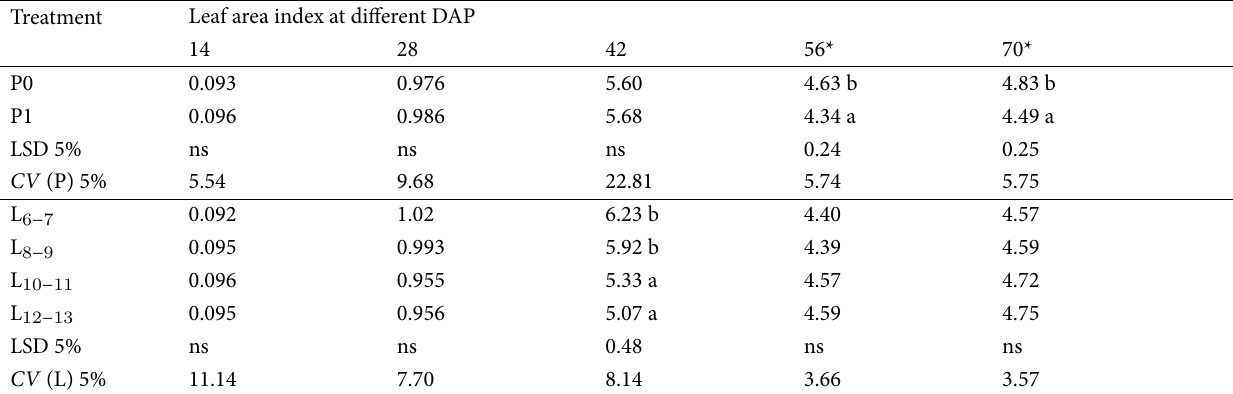
Table 2 Effects of bud trimming and fruit position arrangement on the leaf area index at 14, 28, 42, 56, and 70 DAP. Treatment Leaf area index at different